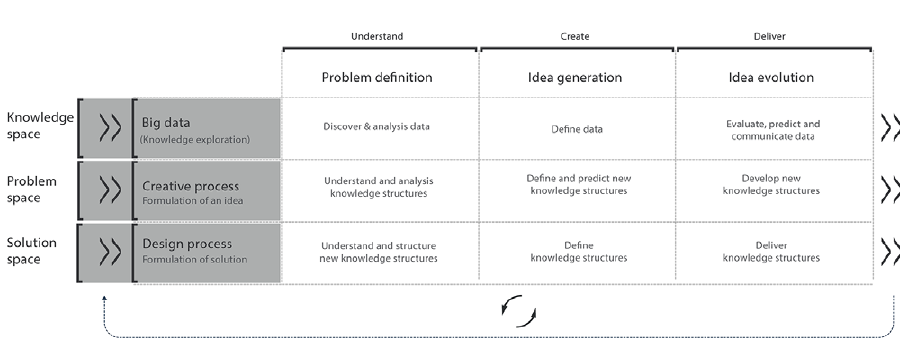
Figure 2. Big data and creative process and design process framework (source: created by